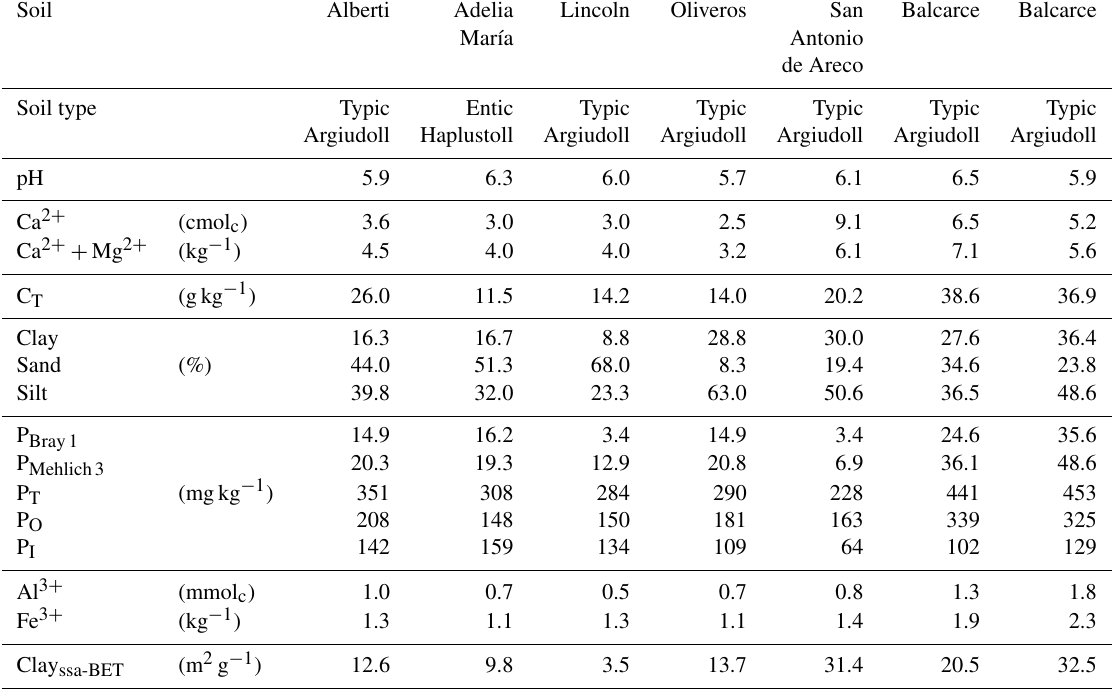
Table 1. Characteristics of seven representative soils of Argentina’s Pampa region used to test phytases adsorption to soils.